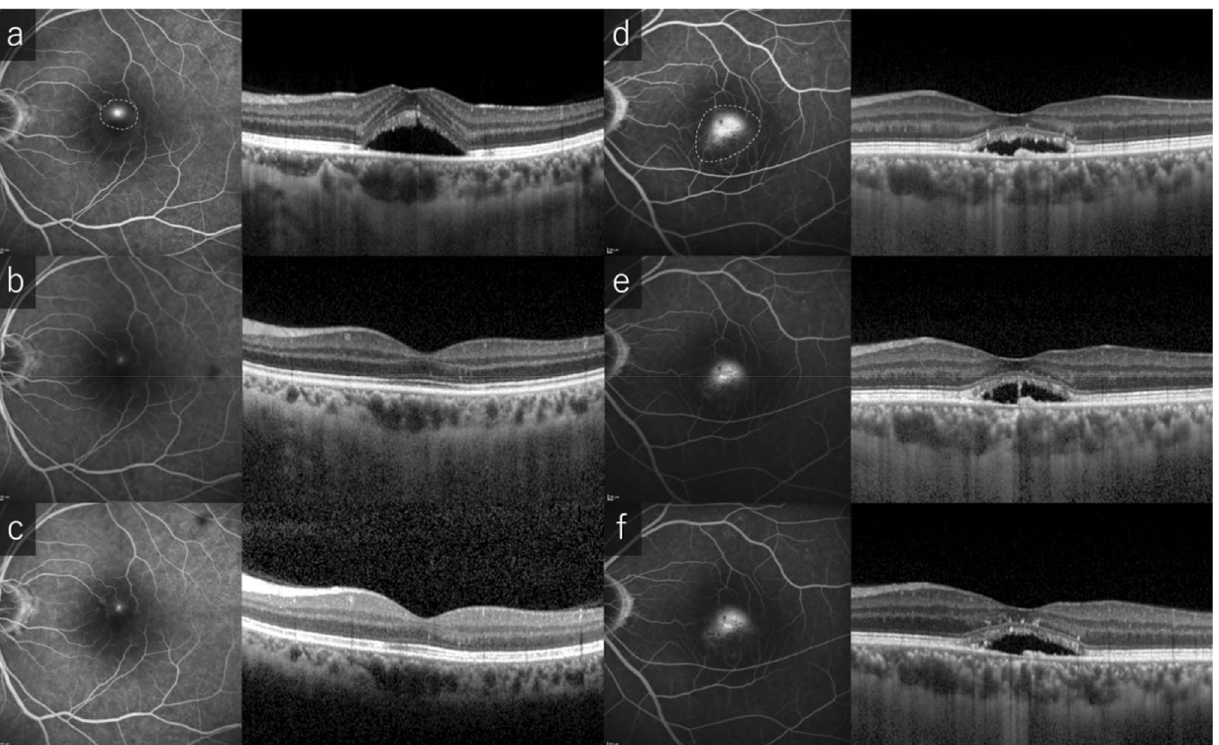
Figure 2. Fluorescein angiography and horizontal line of optic coherence tomography images of patients at baseline ( a , d ), 3 months follow-up ( b , e ) and 6 months follow-up ( c , f ) after selective retina therapy (SRT). Extent of SRT irradiation (within yellow dotted line). ( a )–( c ): 47-year-old, non-smoker male with an 11-year history of vision loss in the left eye. The number of SRT irradiation was 8 and laser energy was ranged from 81 to 103 µJ (optoacoustic, OA value was ranged from 61 to 1009). Focal leakage was disappeared and complete resolution of subretinal fluid (SRF) was seen at 3- and 6-months follow-up. Central macular thickness